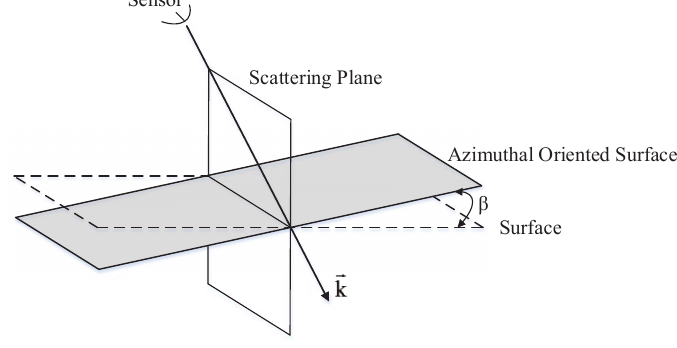
Figure 1. Surface slope